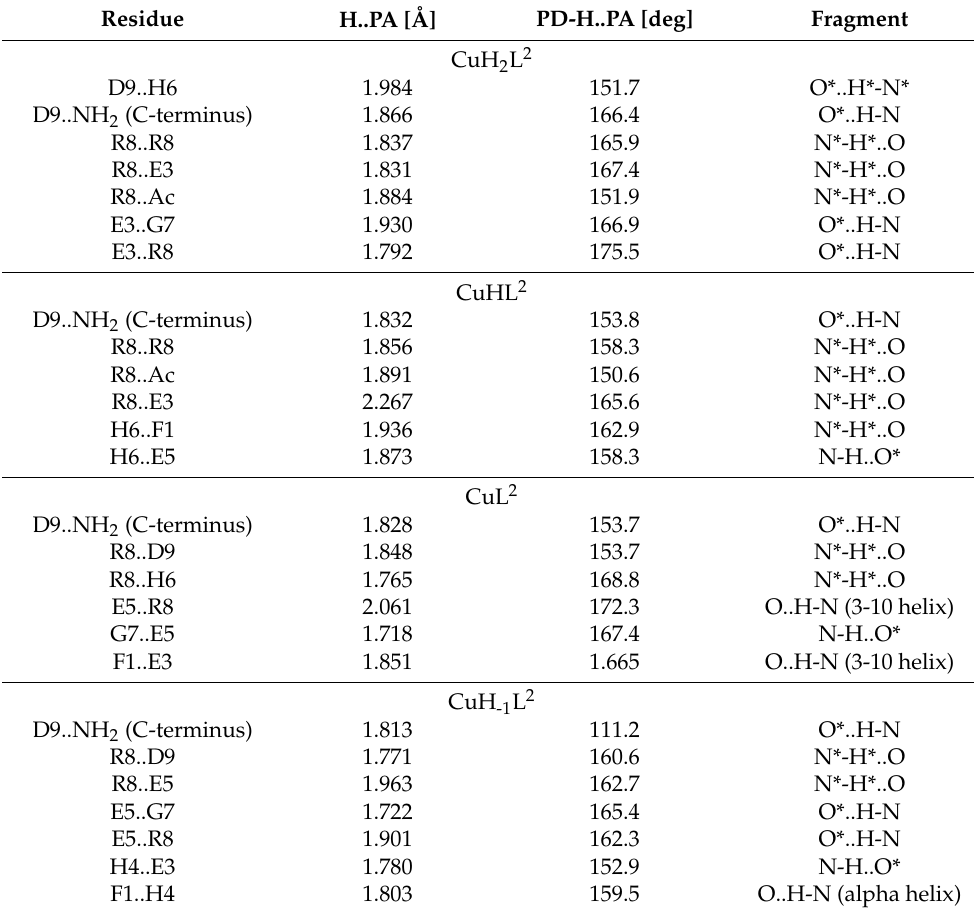
Table 4. Hydrogen bonds of Cu(II)-L 2